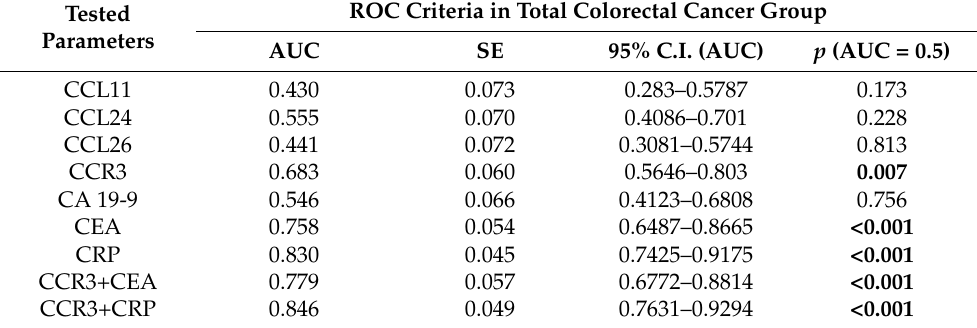
Table 3. AUC of tested parameters in patients with colorectal cancer.